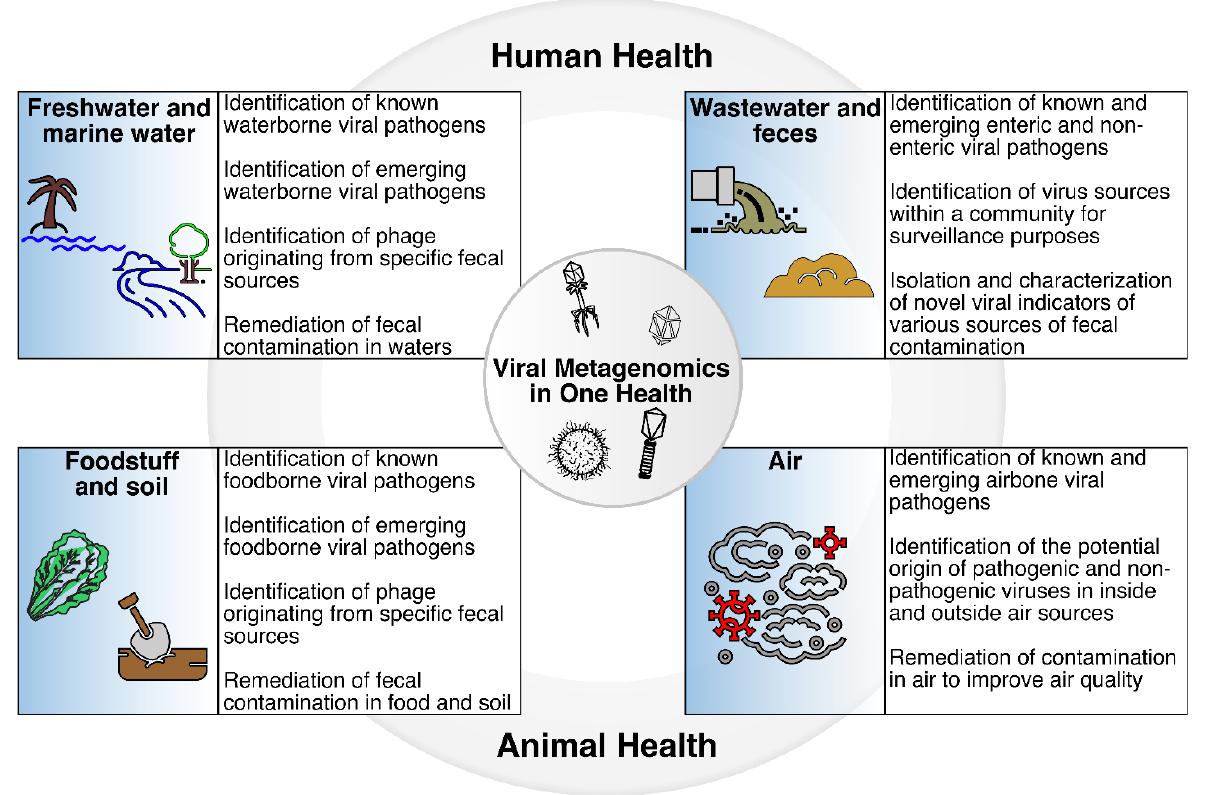
Figure 2. Viral metagenomics in One Health. The introduction of fecal material into water sources, foodstuff, soil, and air has the potential to affect One Health, particularly human and animal health, through exposure to enteric pathogens including viruses. Viral metagenomics may be part of the suite of methods that can be used to identify known and emerging viruses, track sources of fecal contamination, identify new viral indicators of specific sources of fecal contamination, and remediate sources of contamination in various sample types.